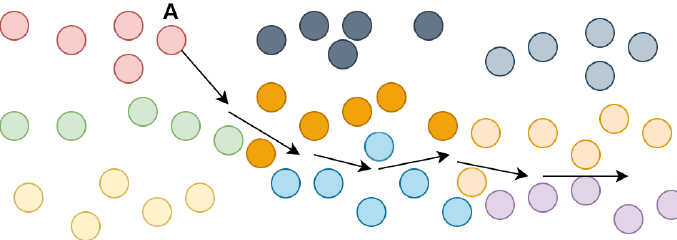
Figure 6. Node behavior